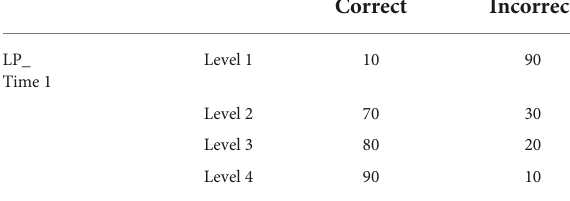
TABLE 2 Conditional probability table for Task 1 given Learning progression at the first measurement occasion (% Probability).